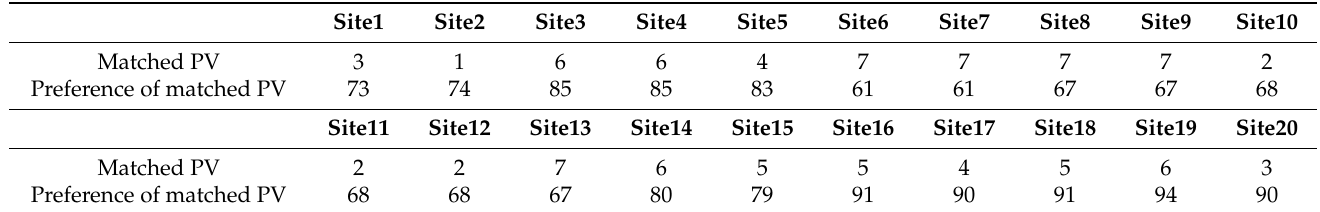
Table 6. Matching results for